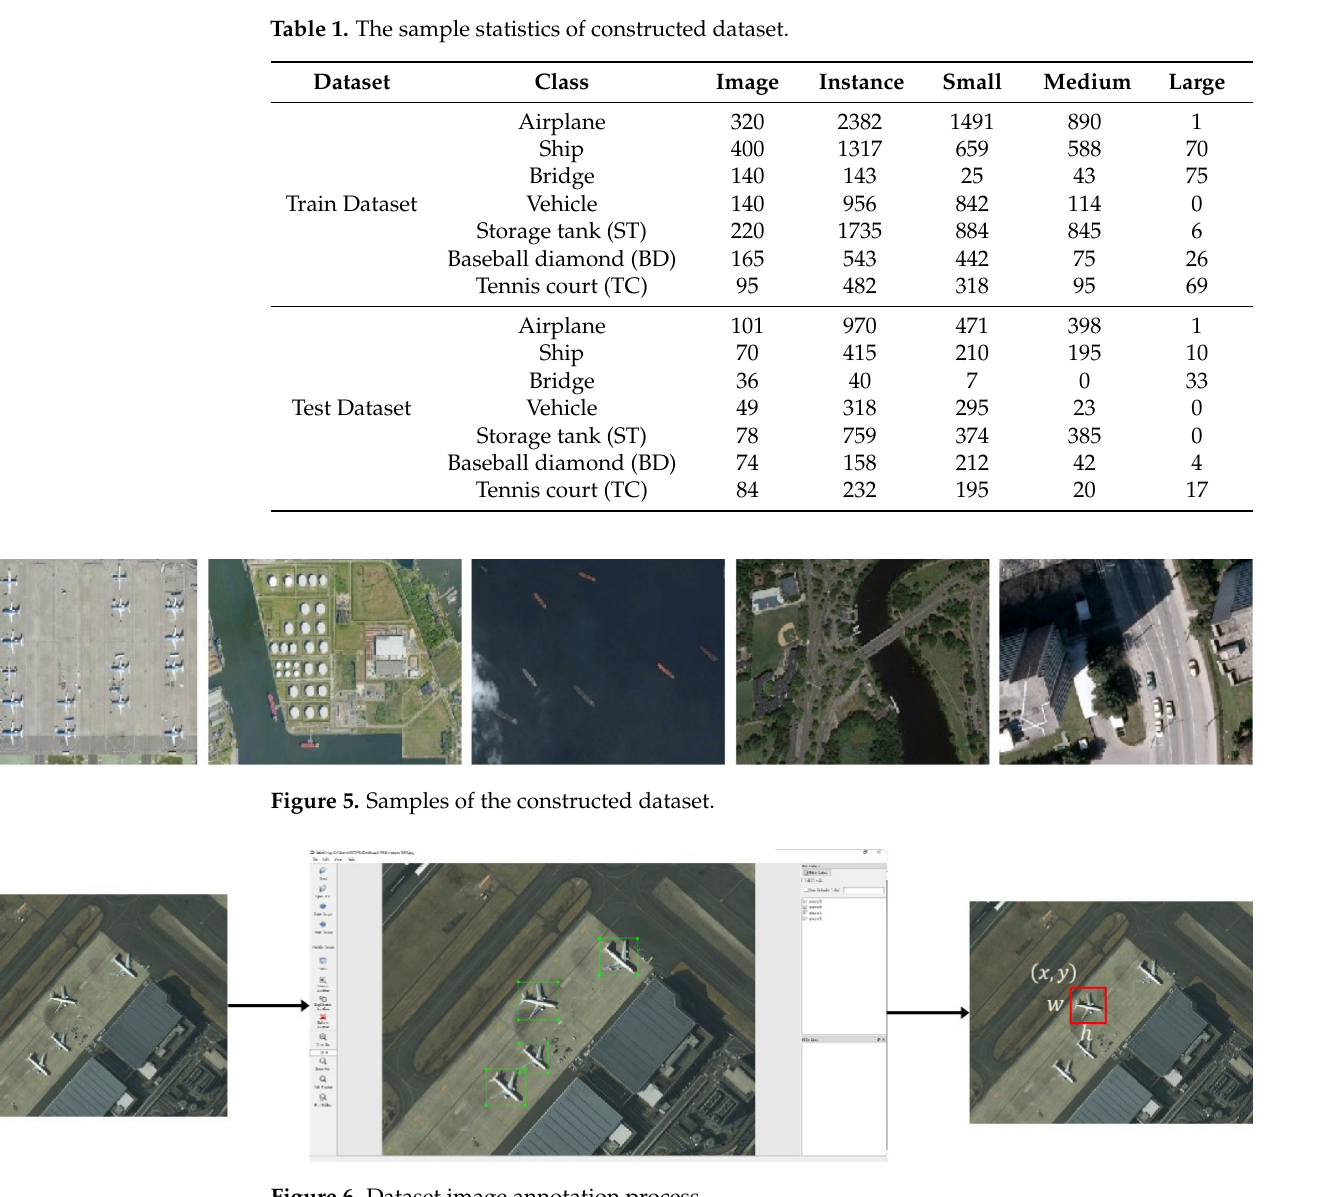
Figure 6. Dataset image annotation